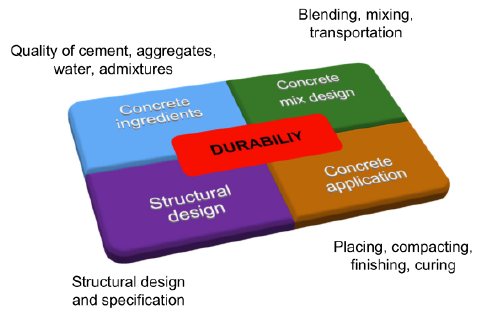
Figure 2. Durability of a concrete and the ability to resist to